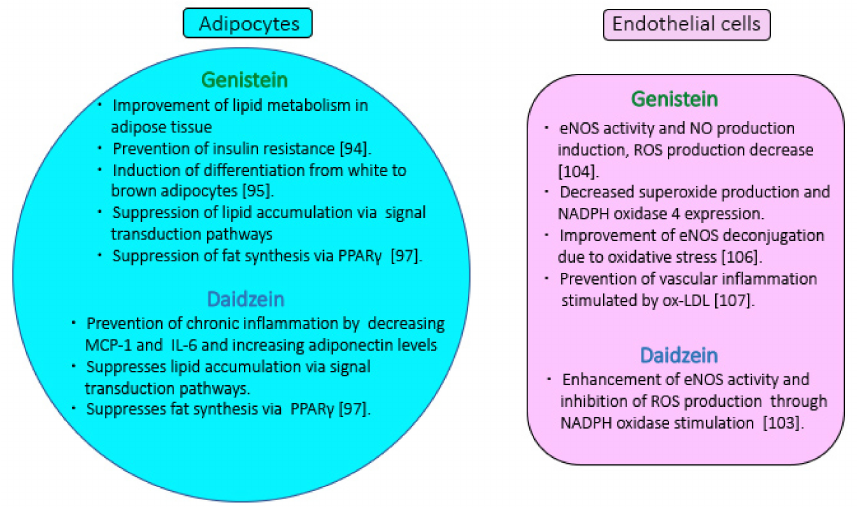
Figure 3. Preventive effects of isoflavones on vascular endothelial cells and adipocytes in- volved in metabolic syndrome. In adipocytes, daidzein blocks inflammation and suppresses fatty acid synthesis [97]. Genistein promotes lipid synthesis, lipid accumulation, and improves lipid metabolism [94,95,97]. Genistein promotes the induction of differentiation into brown adipocytes [95,97]. In vascular endothelial cells, daidzein and genistein enhance the activity of eNOS and block ROS production [104,106]. Genistein improves eNOS uncoupling due to oxidative stress. Genistein inhibits ox-LDL-induced vascular inflammation [107]. Abbreviations: MCP-1, monocyte chemoattractant protein-1; IL-6, interleukin-6; PPAR, peroxisome proliferator-activated receptor; eNOS, endothelial nitric oxide synthase; ROS, reactive oxygen species; ox-LDL, oxidized low-density